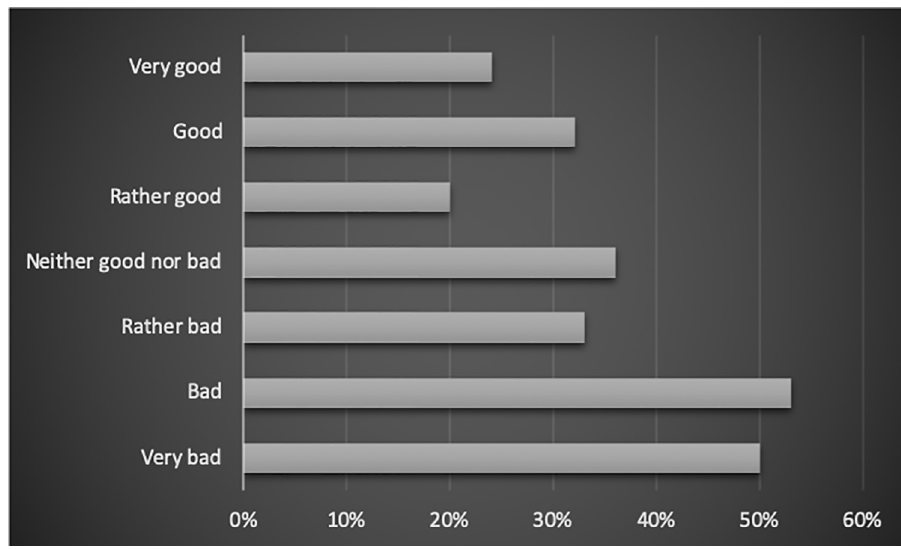
Fig 7. The relation between the subjective assessment of one’s financial situation and employees’ work-life balance (% of people in the category).